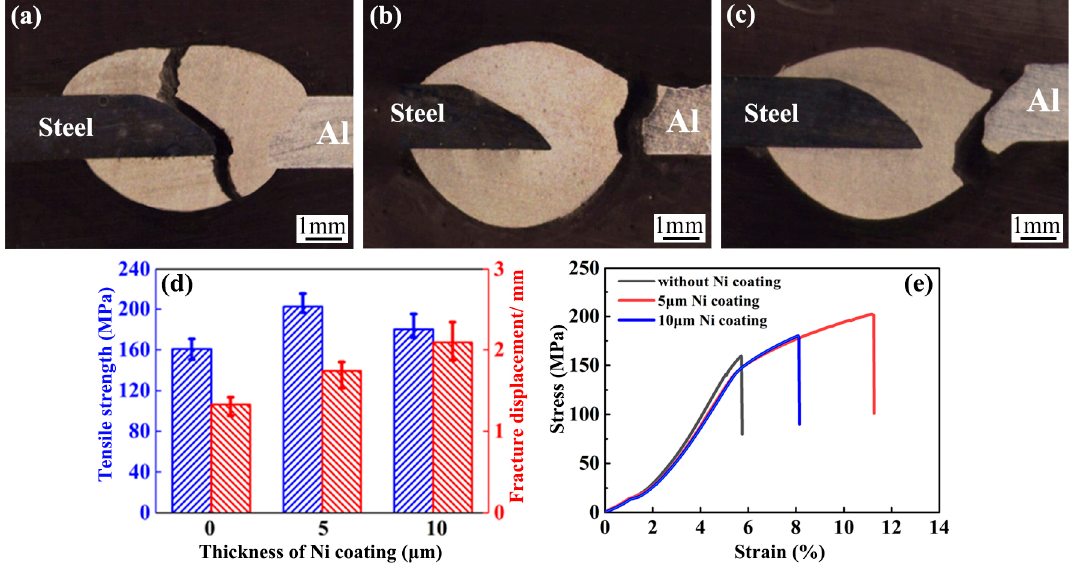
Figure 7. Tensile properties and fracture section morphology of joints: ( a ) fracture location without Ni coating; ( b ) fracture location with 5 μ m Ni coating; ( c ) fracture location with 10 μ m Ni coating; ( d ) Ni coating; ( b ) fracture location with 5 µ m Ni coating; ( c ) fracture location with 10 µ m Ni coating; tensile strength and fracture displacement; ( e ) stress-strain curves. ( d ) tensile strength and fracture displacement; ( e ) stress-strain